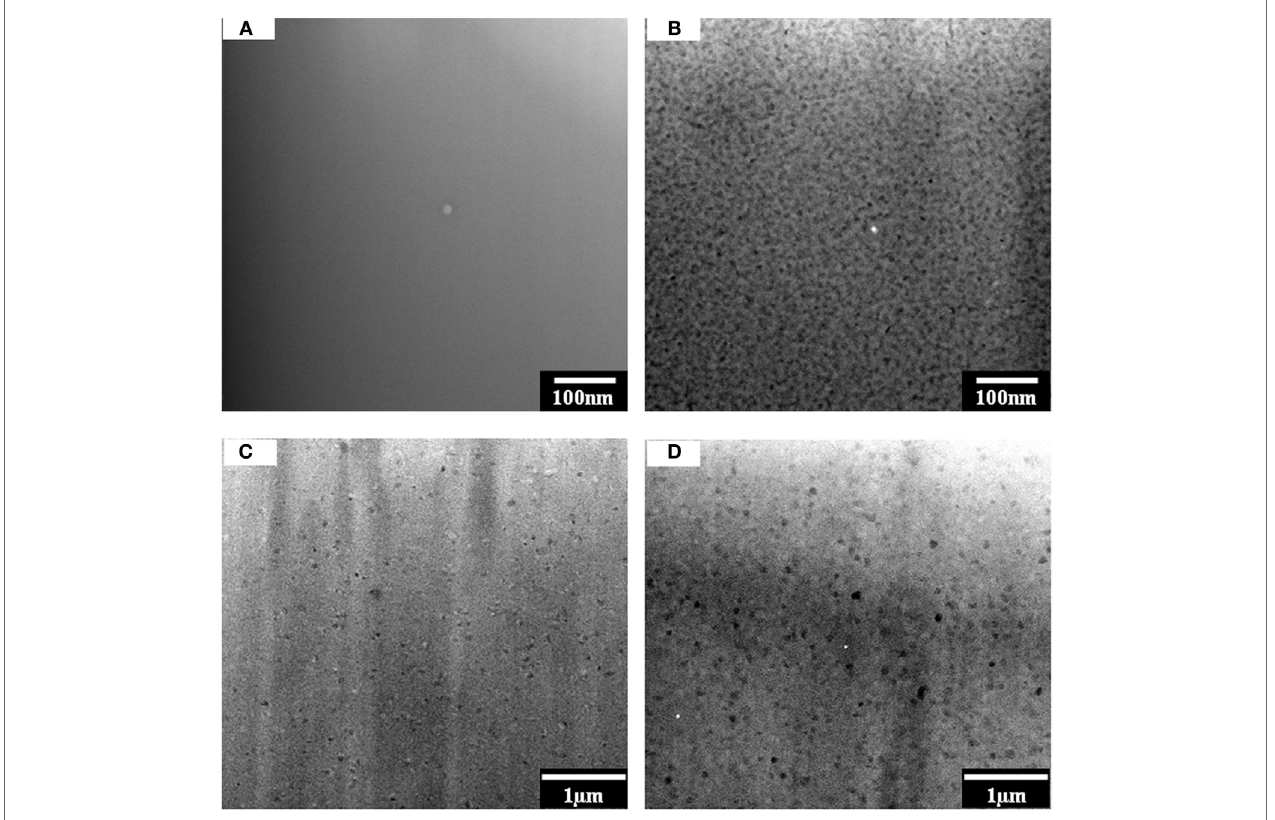
FigUre 4 | TeM of nucleated glass composition #5: (a) green glass; (B) after holding at 750°c for 1.0 h showing phase separation; (c) low magnification showing the formation of β -quartz ss after at 750°c for 1.0 h; (D) more β -quartz ss after holding at 750°c for 4.0 h